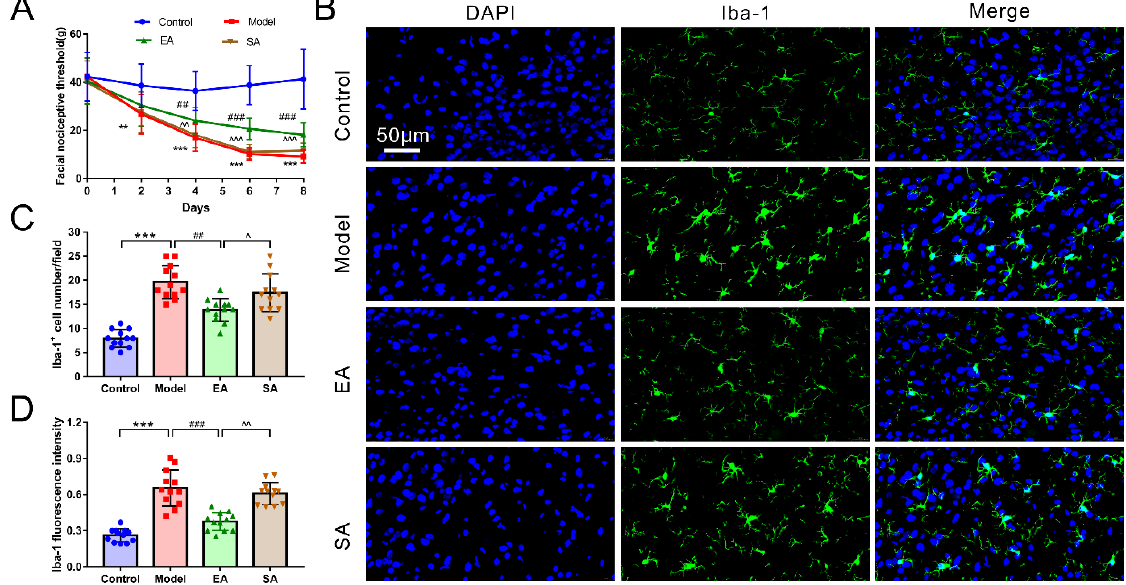
Figure 2. Facial nociceptive threshold and Iba-1-labeled microglia activation in the TNC among groups. ( A ) Facial nociceptive threshold among groups at all time points throughout the experiment ( n = 20/time point/group); ( B ) Images of microglia labeled with Iba-1 immunofluorescence staining in TNC (400×, Scale bar = 50 µm, n = 4, three sections/rat); ( C ) Number of Iba-1-labeled microglia cell ( n = 4, three sections/rat); ( D ) Iba-1-labeled microglia fluorescence intensity ( n = 4, three sections/rat). One-way ANOVA followed by post hoc Tamhane test. Data are mean ± SD. ** p < 0.01, *** p < 0.001, model versus control. ## p < 0.01, ### p < 0.001, EA versus model. ˆ p < 0.05, ˆˆ p < 0.01, ˆˆˆ p < 0.001, SA versus